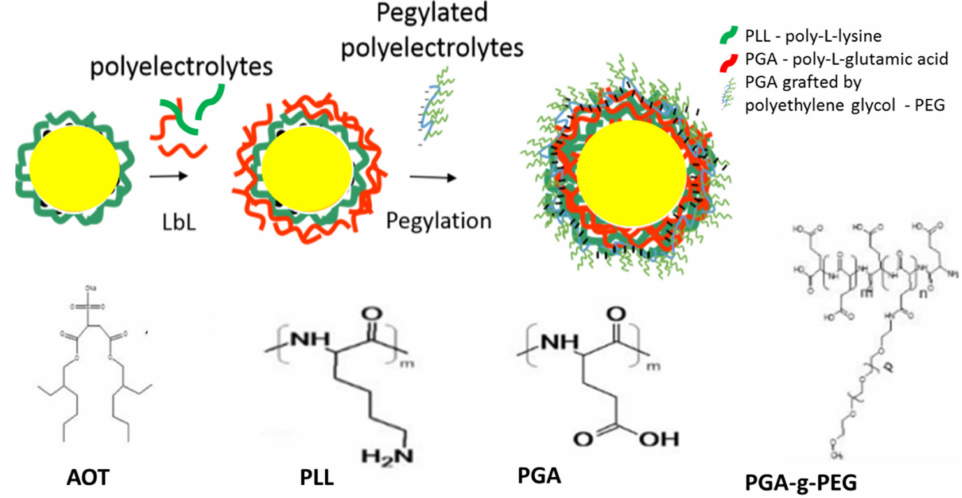
Figure 1. Structure of obtained polymeric